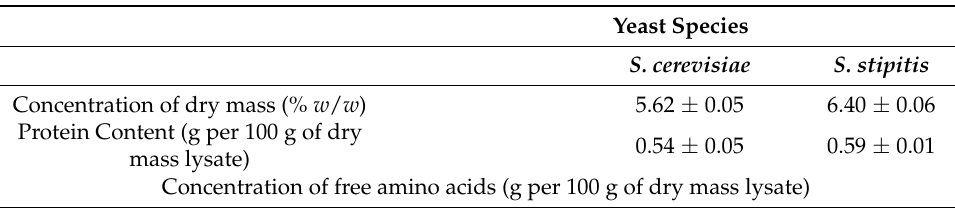
Table 6. Amino acid (AA) profiles and protein concentration in yeast autolysates by high-pressure liquid chromatography, adapted from